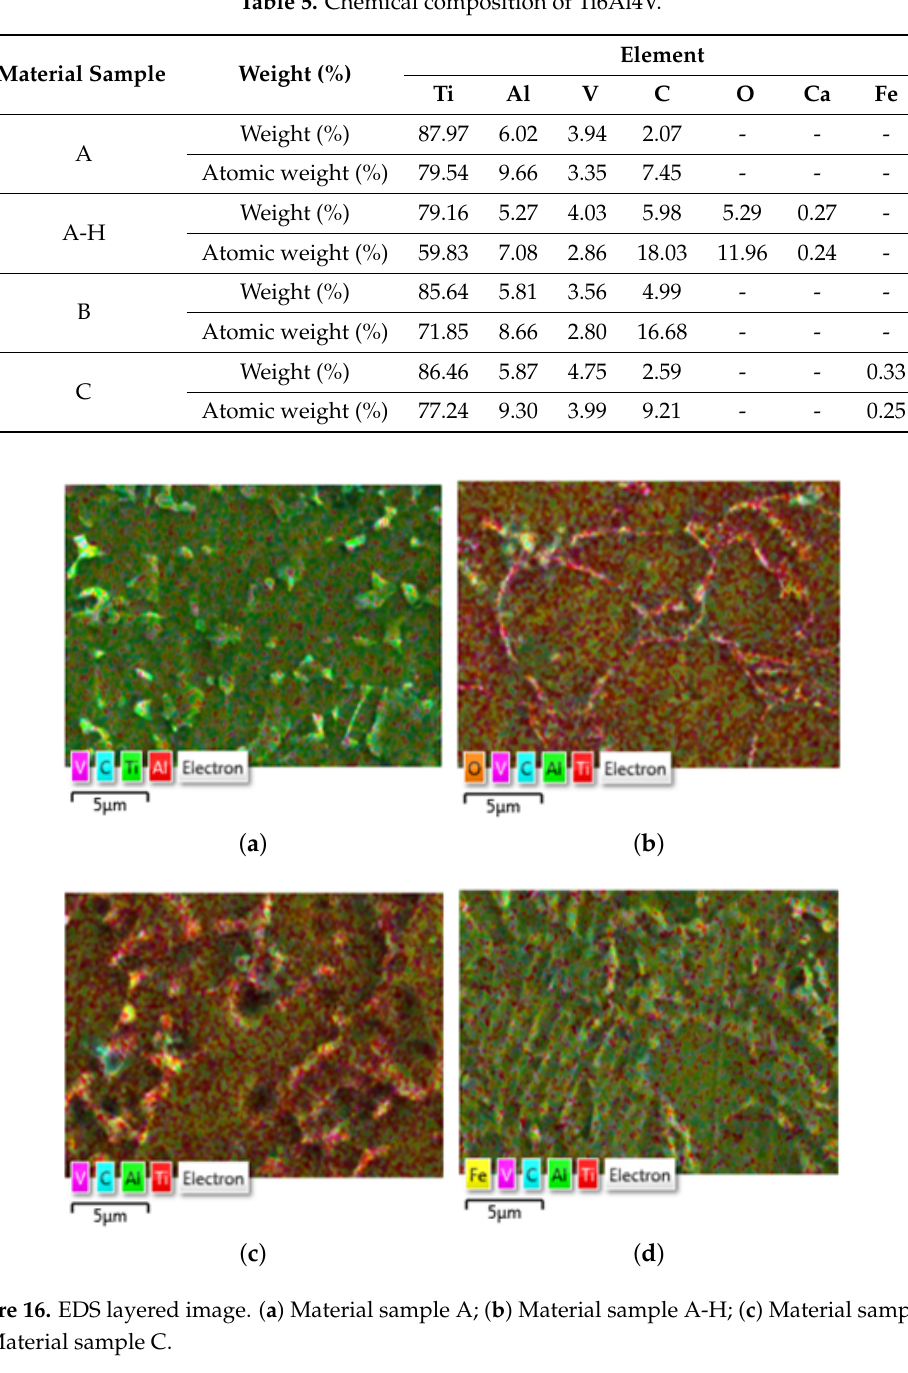
Table 5. Chemical composition of Ti6Al4V.